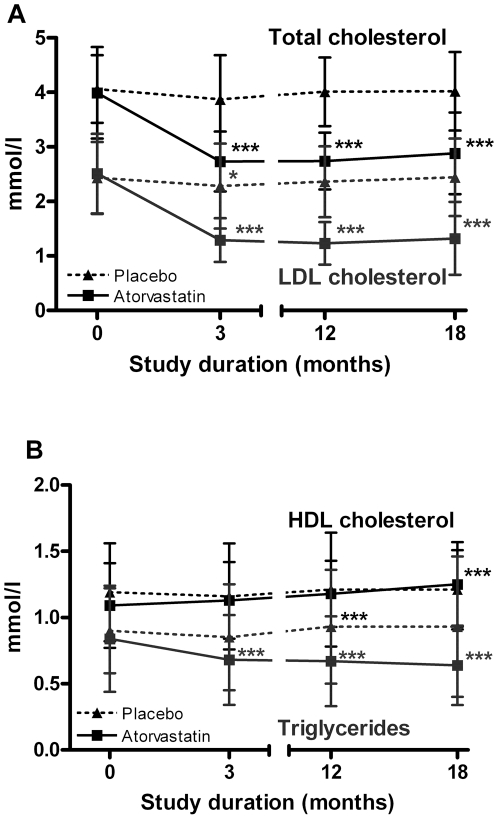
Effect of atorvastatin on blood lipid levels.Shown are mean levels of total (black lines) and LDL-cholesterol (blue
lines) (a), HDL-cholesterol (black lines) and triglycerides
(blue lines) (b), bars indicate standard deviation, dotted
lines depict placebo, continuous lines atorvastatin. * p<0.05,
** p<0.01, *** p<0.001 for comparison with
baseline values. Only changes for the atorvastatin group are
significant.